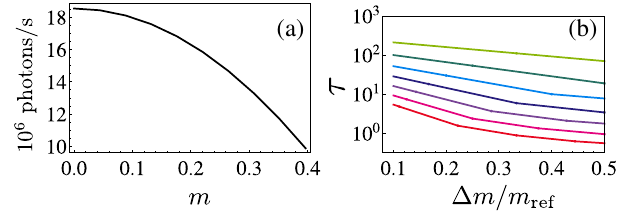
FIG. 19. Finite-temperature plots of (a) collected photon rates vs the MFT AFM-order parameter m with a lens of NA ¼ 0 . 8 in the forward direction, and (b) the corresponding estimated number of experimental realizations to achieve a relative accu- racy Δ m=m . Results are obtained with MFT at finite T with ref fixed U ¼ 5 . 3 J , and with s ¼ 25 and κ ¼ 1 . 05 . The cross block width is 0.048 rad. At fixed U , increasing T leads to decreasing m , and in (b), we show from top to bottom (corresponding to ¼ 0 . 13 , 0.18, 0.22, 0.26, 0.31, 0.35, 0.4. In (b), lowering T ), m ref the data points are joined with straight